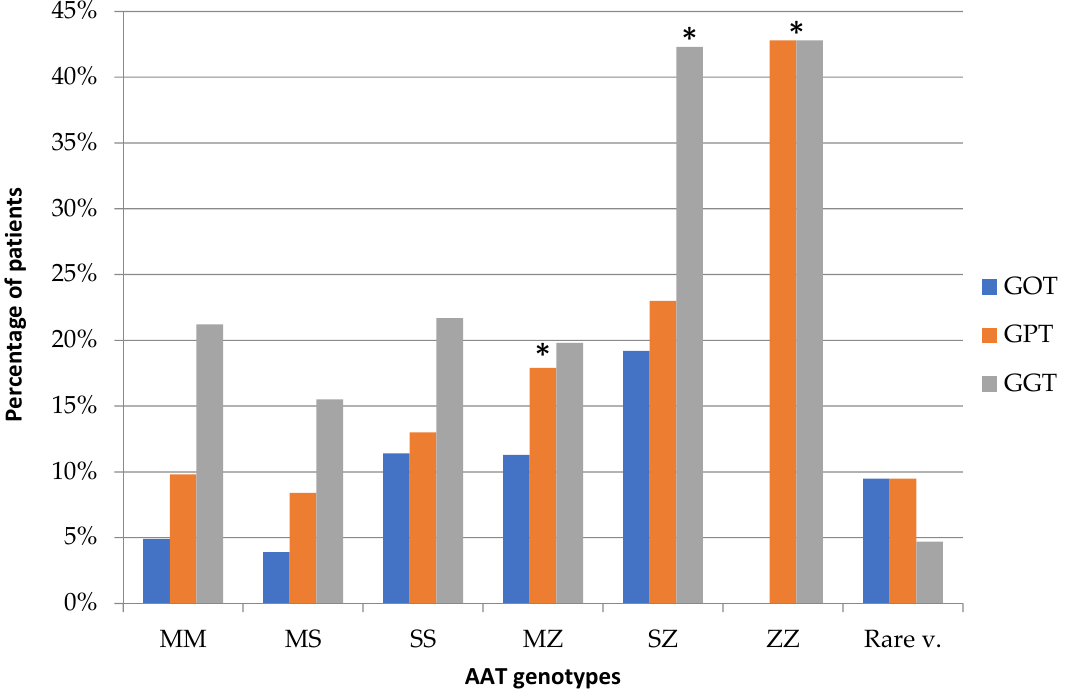
Figure 1. Relationship between genotypes and transaminase levels (IU / L). Transaminases (GOT > 37 U / L), (GPT > 38 U / L), and (GGT > 40 U / L). It can be seen that the most deficient genotypes are those that cause the greatest significant increases in transaminases levels ( p < 0.05). * In the Pi*ZZ genotype, no changes in GOT levels were